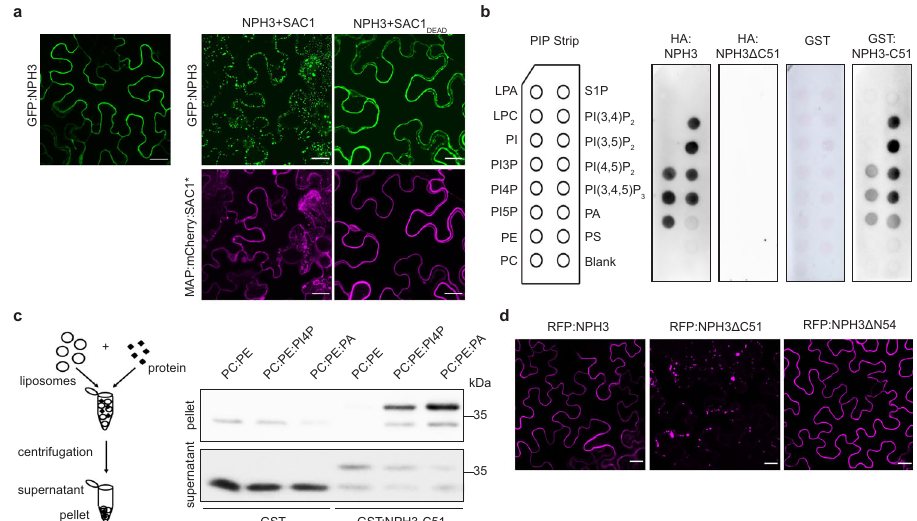
Fig. 1 NPH3 binds to polyacidic phospholipids via its C-terminal domain. a Representative confocal microscopy images of leaf epidermal cells from dark- adapted N. benthamiana transiently co-expressing GFP:NPH3 and either MAP:mCherry:SAC1 or MAP:mCherry:SAC1 DEAD . Expression was driven by the 35S promoter. Z -stack projection of GFP:NPH3 co-expressed with MAP:mCherry:SAC1 is shown. Single expression of GFP:NPH3 is shown as control. Scale bars, 25 μ m. b Lipid overlay assay performed with either in vitro-transcribed and -translated HA:NPH3 and HA:NPH3 Δ C51 or puri fi ed GST and GST:NPH3- C51. Immunodetection was conducted by using anti-HA or anti-GST antibodies, respectively. See main text for abbreviations of lipids. c Liposome-binding assay performed with puri fi ed GST or GST:NPH3-C51 and large unilamellar liposomes containing the neutral phospholipids PE and PC mixed with either the polyacidic PI4P or PA as speci fi ed. Anti-GST immunoblot of pellet and supernatant is shown (lower band corresponds to GST, upper band to GST:NPH3- C51). d Representative confocal microscopy images of leaf epidermal cells from dark-adapted N. benthamiana transiently expressing RFP:NPH3 Δ C51 ( Z - stack projection) or RFP:NPH3 Δ N54. Expression was driven by the 35S promoter. RFP:NPH3 is shown as control. Scale bars, 25 μ m. All experiments were performed at least three times with similar domain, Supplementary Fig. 1) abolished lipid binding, whereas the glutathione S-transferase (GST), GST:NPH3-C51) turned out to be